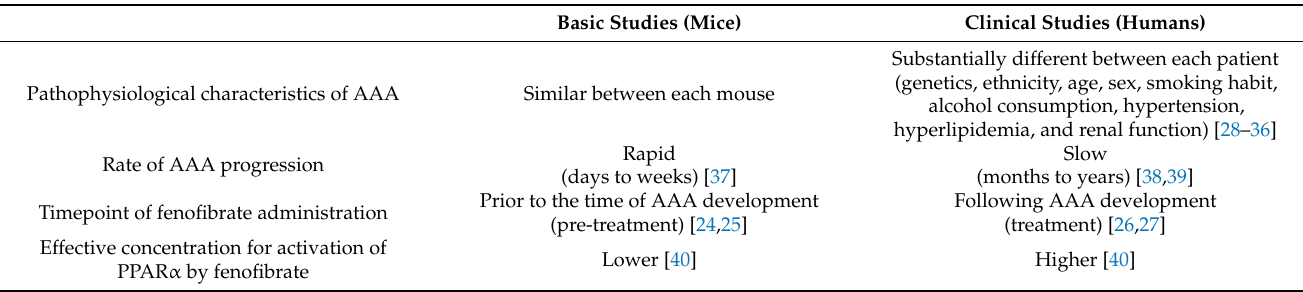
Table 1. Difference in the progression and treatment of abdominal aortic aneurysm following fenofibrate administration in mice and